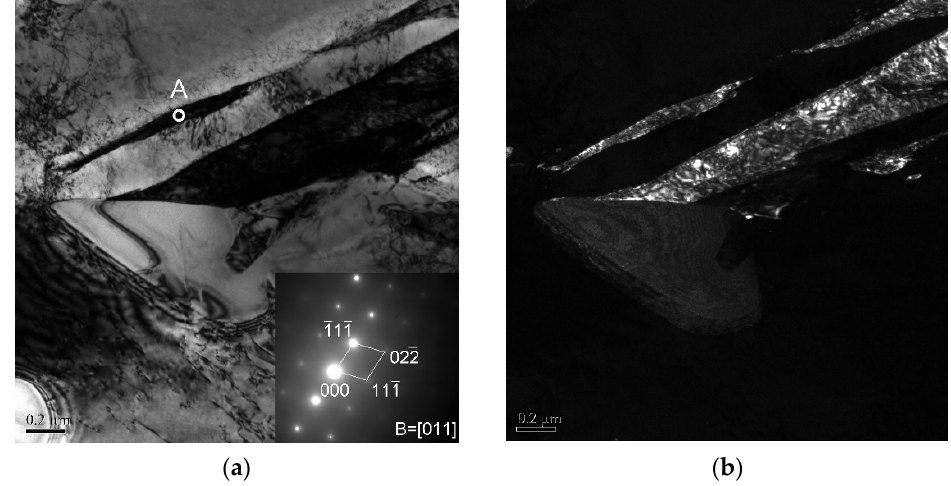
Figure 5. The TEM morphology of 1 Mn in process 2, ( a ) bright field of lath austenite; ( b ) dark field of lath austenite. Table 3. Austenite fraction and carbon content in austenite, obtained from X-ray diffraction (XRD) and EBSD results.